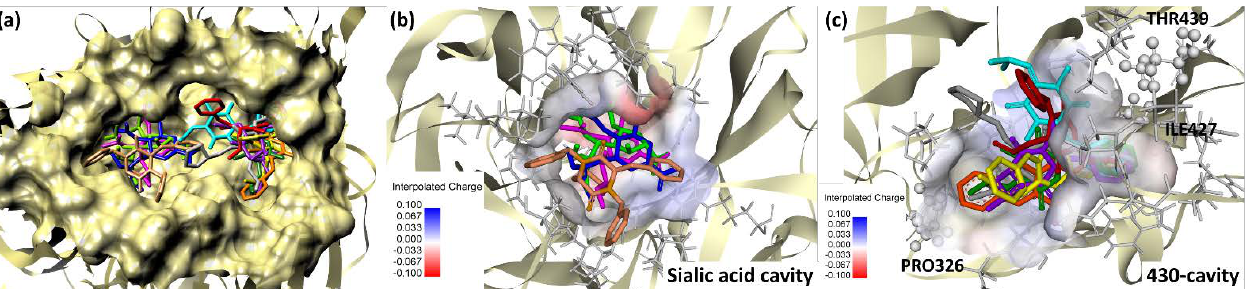
Figure 3. Comparison of the binding position of oseltamivir carboxylate (blue), zanamivir (pink), peramivir (light green), LS-C (sky blue), compound 7 (light brown), 9 (purple), 13a (orange), 13b (red), 13c (yellow), 13d (dark green), and 14c (gray) in whole cavity ( a ), in the sialic acid cavity ( b ) and in the 430-cavity (c) of neuraminidase from H5N2 avian influenza virus. Table 2. Summary of binding energies, amino acid interaction, and hydrogen bond length of 2,5- diketopiperazine derivatives, oseltamivir carboxylate in molecular docking studies .